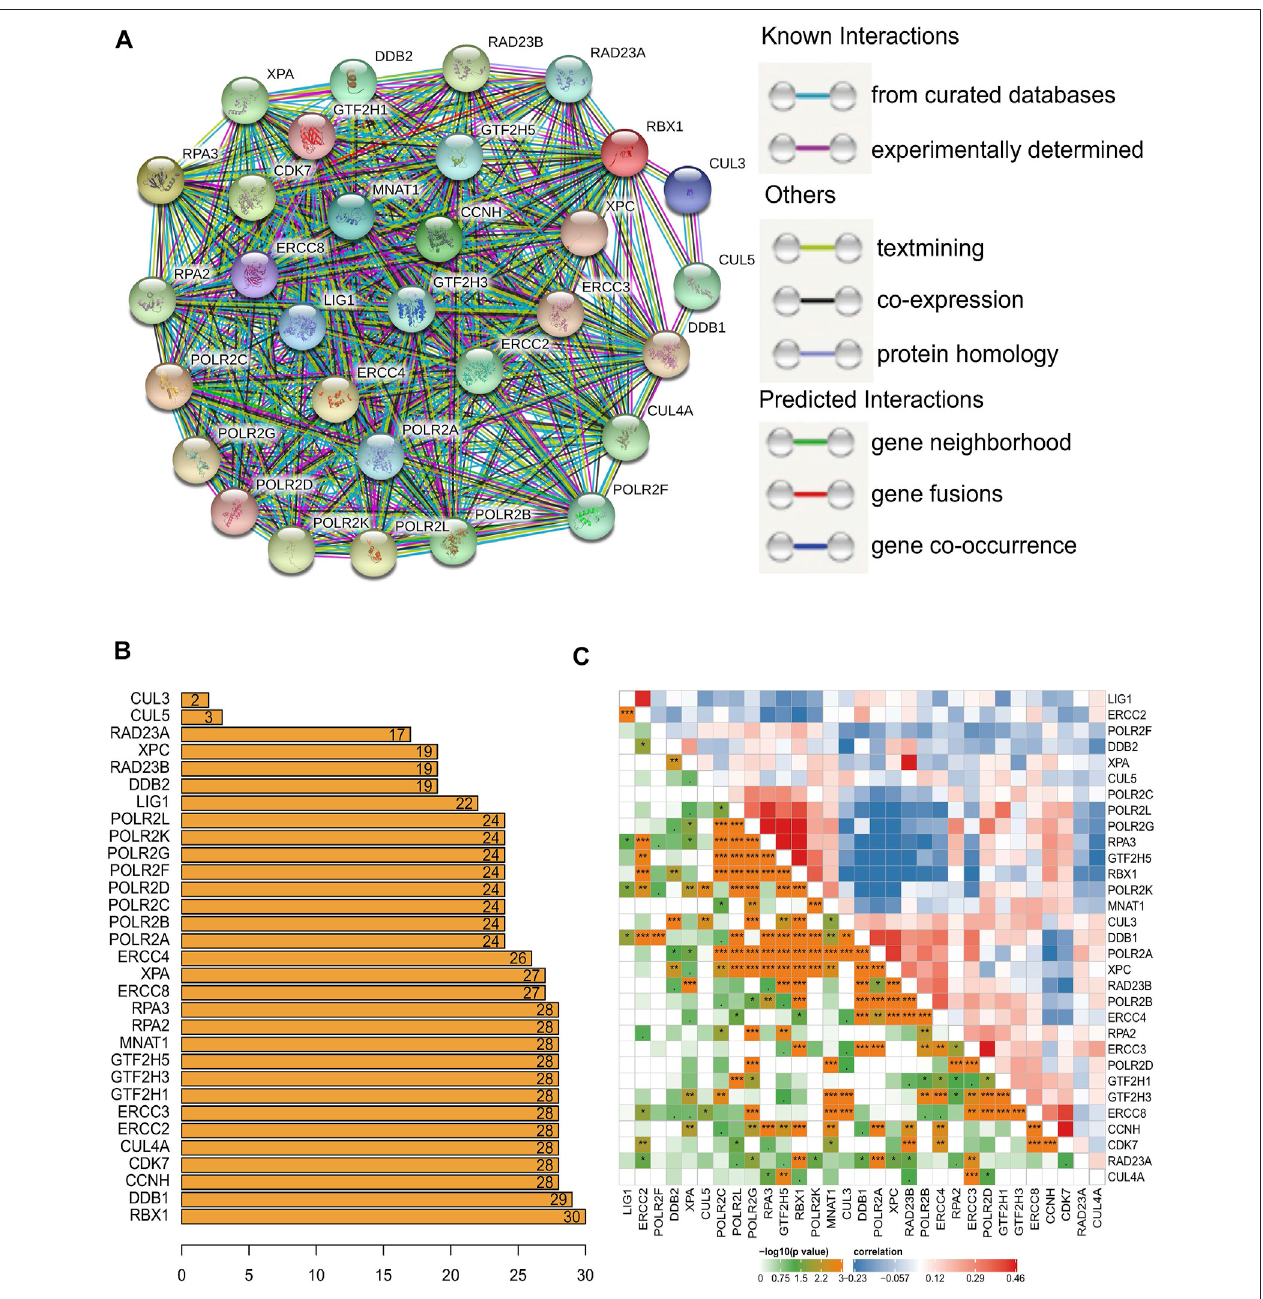
FIGURE2| Theinteractionandcorrelationamong31NER-relatedgenes. (A) ThePPInetworkofthe31NER-relatedgeneswasconstructedbySTRINGdatabase and each linerepresentsareported physical protein – protein interaction between nodes. (B) Thenumber ofbar graphsrepresentsthe totalconnections ofeach node to other nodes frequency. (C) The Pearson correlation analysis shows the collinearity among 31 NER-related genes. Abbreviation: NER: Nucleotide excision repair; PPI: Protein-protein interaction; STRING: the Search Tool for the Retrieval of Interacting Genes.